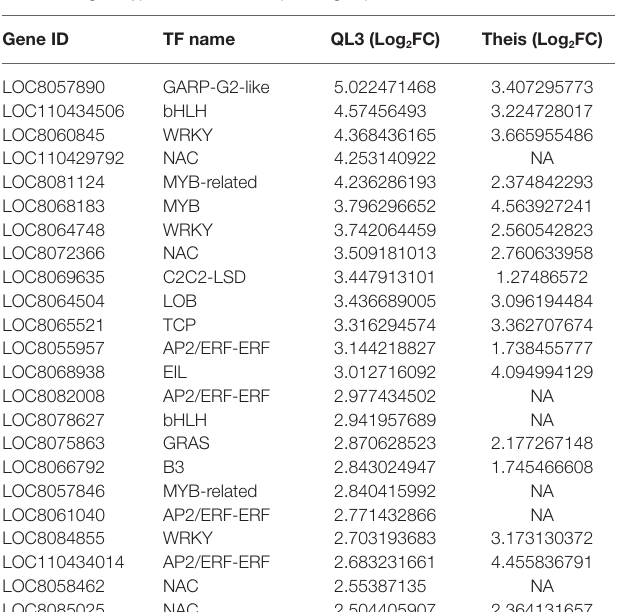
TABLE 4 | Differentially expressed genes with transcription factors upregulated in resistant genotype QL3 and corresponding expression in